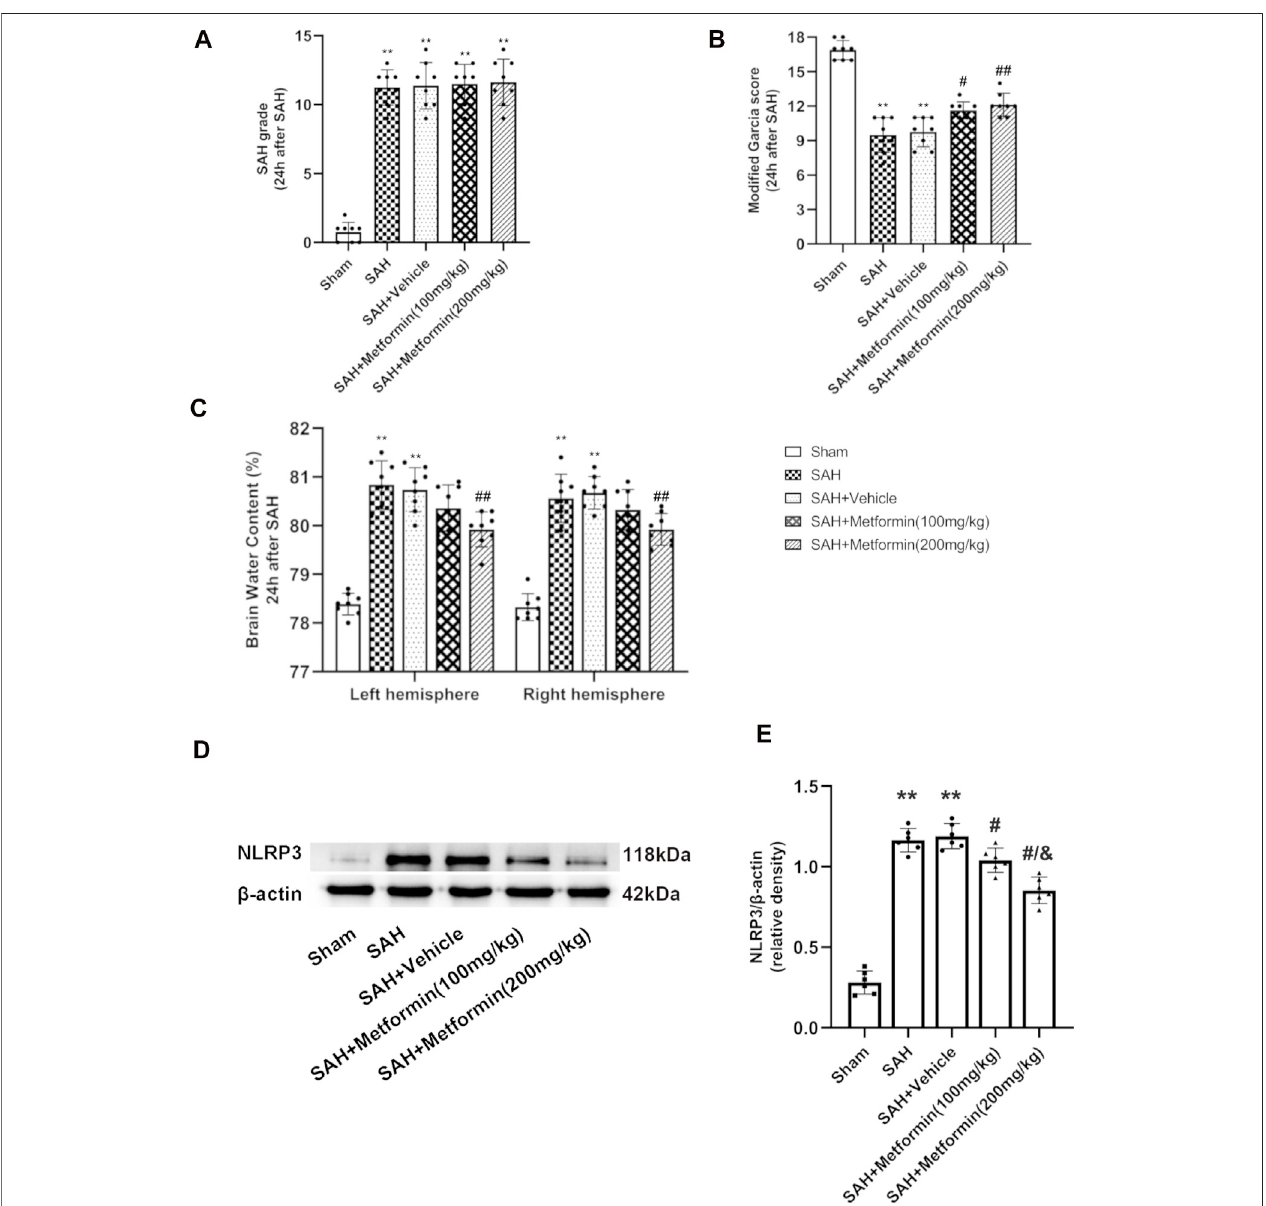
FIGURE 4 | Metformin attenuates short-term neurological de fi cit and brain edema at 24 h after SAH. (A) The SAH grades for each group. (B) Modi fi ed Garcia scores for each group. (C) Quanti fi cation of brain water content 24 h after SAH. (D) Representative Western blot images. (E) Quantitative analyses of NLRP3. N = 6 for each group. Bars represent mean ± SD. ** p < 0.01 vs. sham group. # p < 0.05, ## p < 0.01 vs. SAH + Vehicle (normal saline) group. & p < 0.05 vs. SAH + Metformin (100